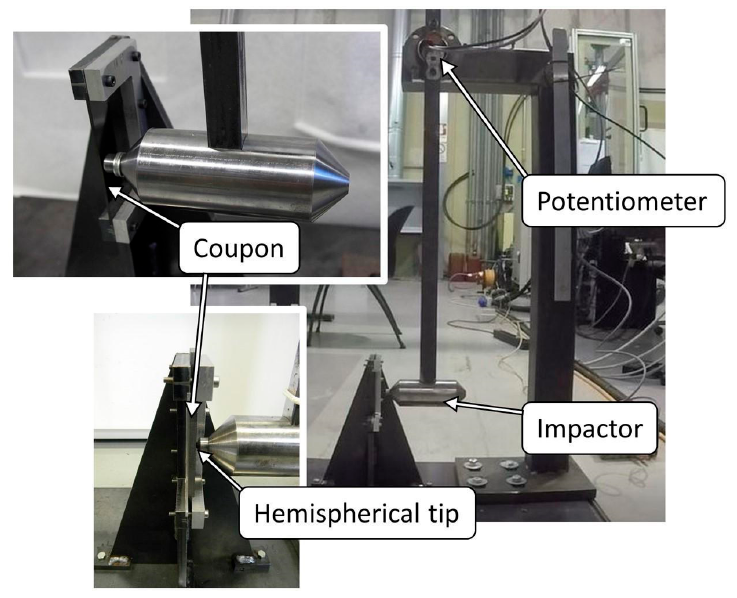
Figure 1. Equipment used for the impact tests (Modified Charpy pendulum).